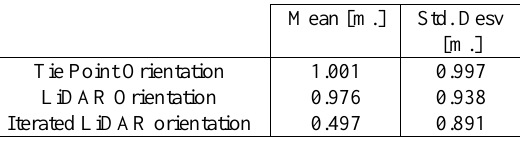
Table 4: 2001 Statical Evolution